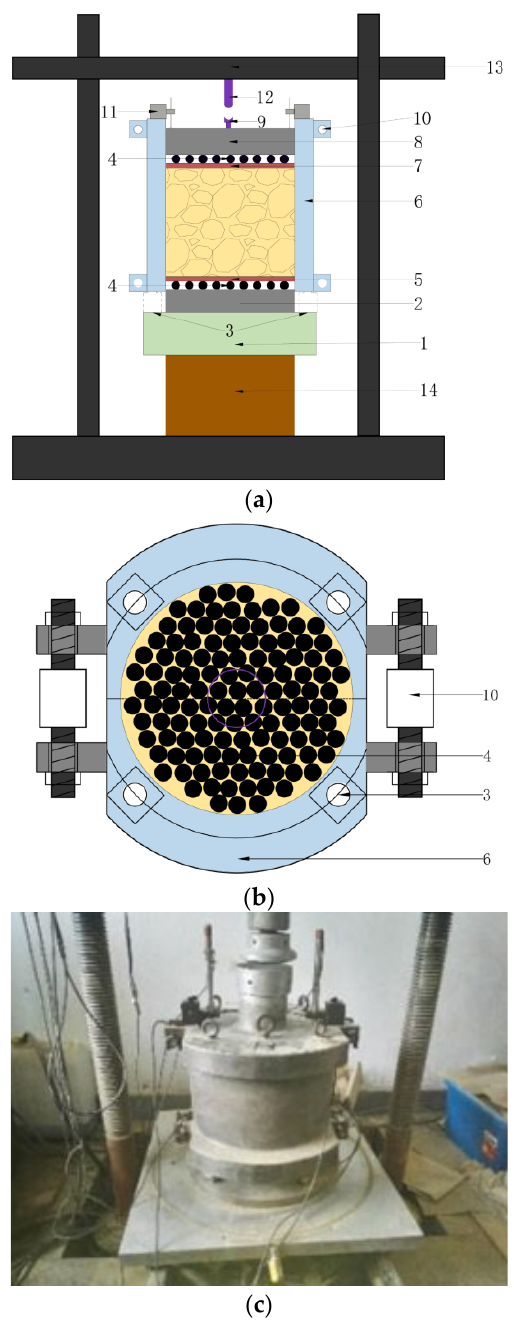
Figure 1. Test equipment (Note: 1—pedestal, 2—base, 3—load sensor, 4—steel ball, 5—the bo tt om force transmission plate, 6—semicircular rigid cylinders, 7—the top force transmission plate, 8— pressure plate, 10—tension sensors, 11—displacement sensor, 12—load sensor, 13—loading frame, and 14—loading device). ( a ) Sketch map of test equipment, ( b ) top view of the apparatus, and ( c ) physical view of the instrument.